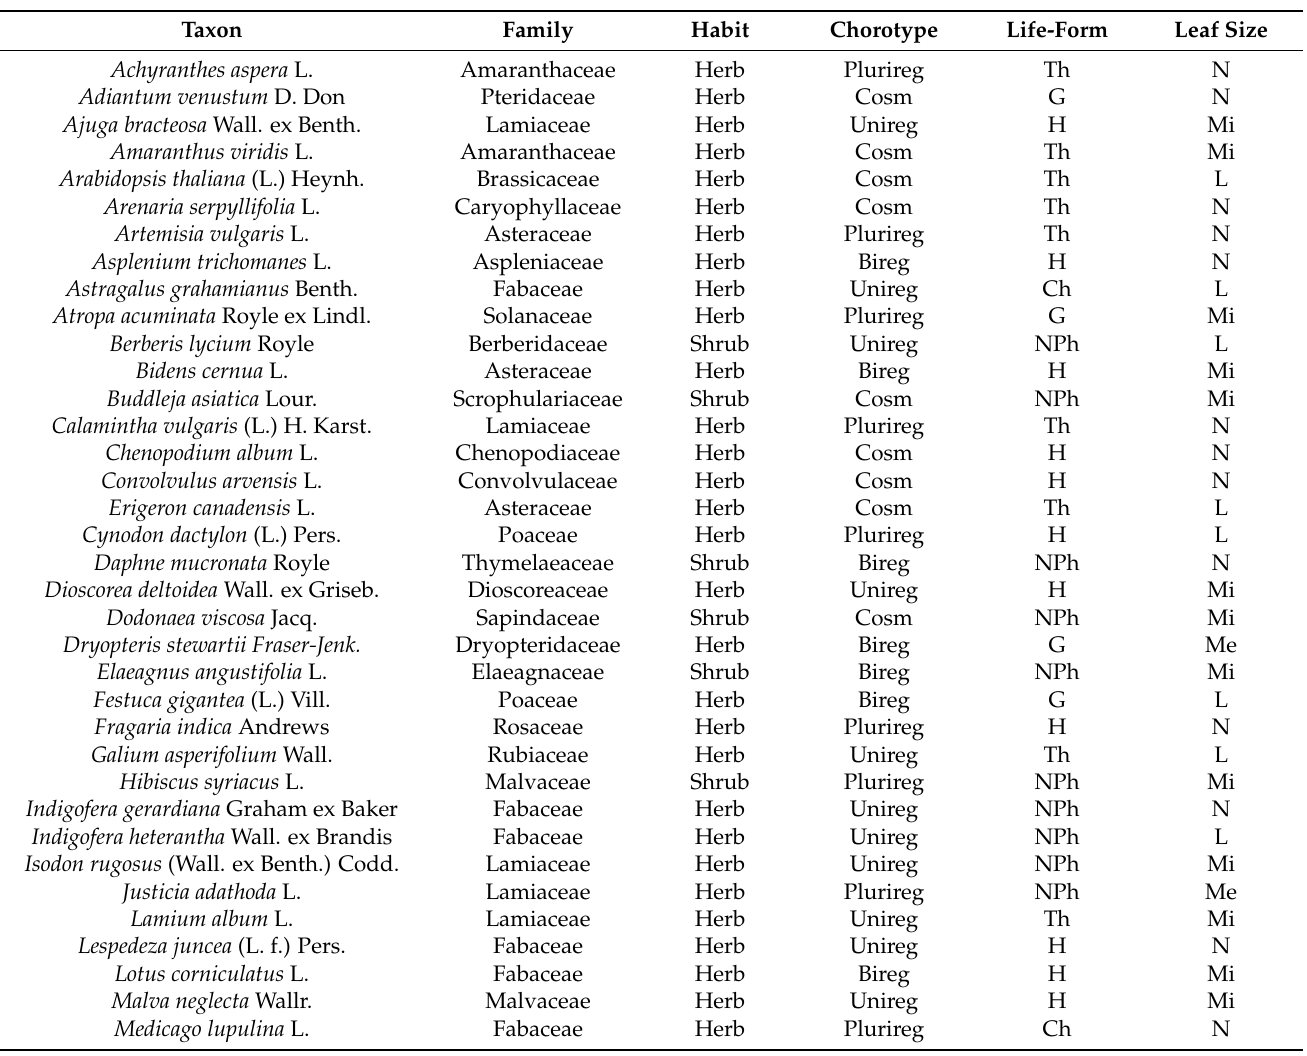
Table 1. List of the plant species with the family names, growth form/habit, chorotype, life-form, and leaf size classes that were recorded in understory vegetation of oak-dominated forests of Swat,